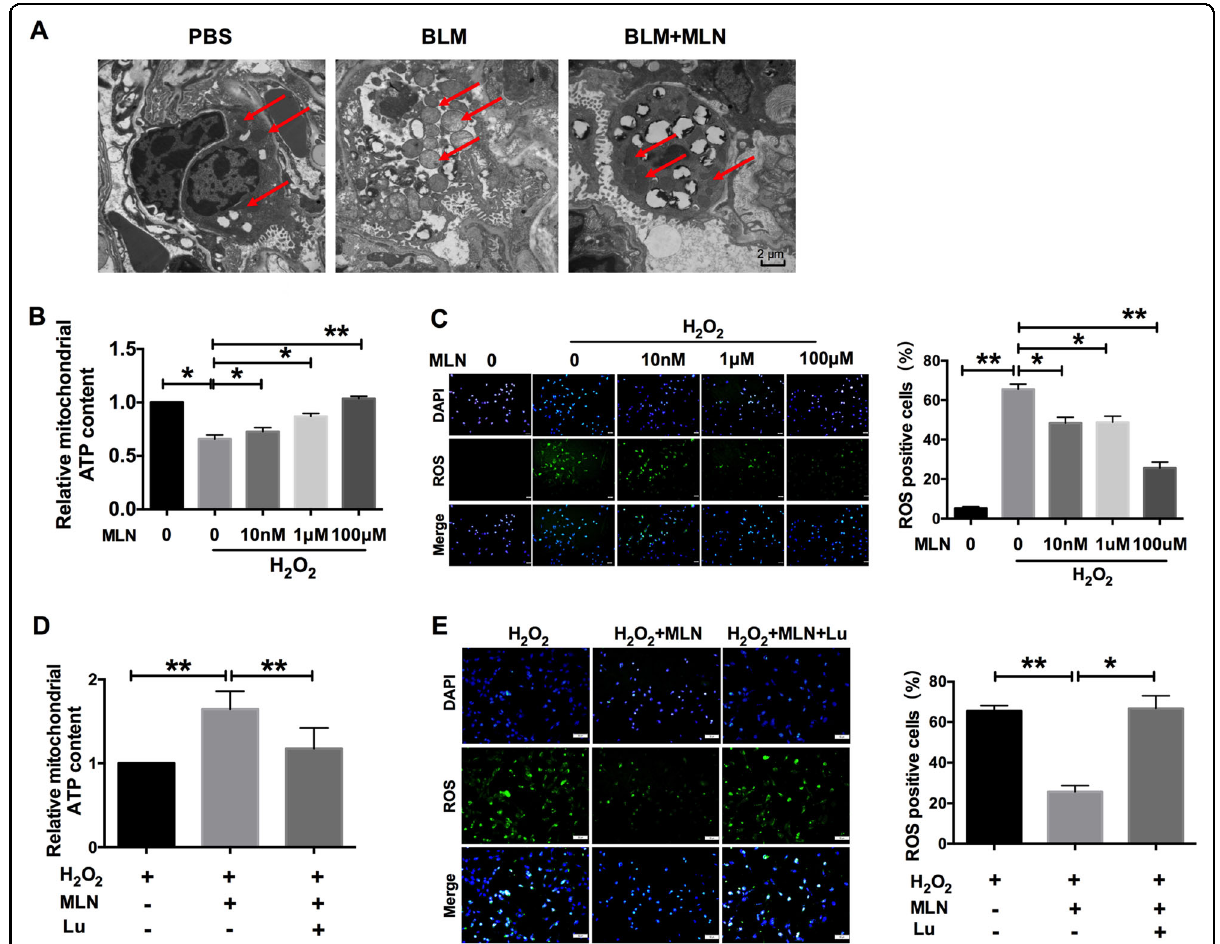
Fig. 4 Melatonin reversed bleomycin-induced mitochondrial abnormalities in alveolar epithelial cells. a Representative transmission electron microscopy (TEM) images of lung sections from mice treated with PBS, BLM, or BLM + MLN. The red arrows indicate normal mitochondria or damaged and swollen mitochondria. b Cellular ATP content was measured in TC-1 cells incubated with the indicated concentrations of H 2 O 2 and melatonin. Cells were lysed, and the ATP content was determined using an ATP assay and normalized to the protein concentration. n = 5; * P < 0.05, ** P < 0.01. c Comparison of ROS production in TC-1 cells exposed to H 2 O 2 with or without melatonin (10 nM, 1 μ M, or 100 μ M). Green, ROS; blue, DAPI. Scale bars, 50 μ m. * P < 0.05, ** P < 0.01. d Measurement of ATP content in TC-1 cells after exposure to H 2 O 2 , melatonin, and luzindole; the ATP content was normalized to the corresponding protein concentration. n = 5; ** P < 0.01. e Effect of luzindole on ROS production in TC-1 cells. Green, ROS; blue, DAPI. Scale bars, 50 μ m. * P < 0.05, ** P <